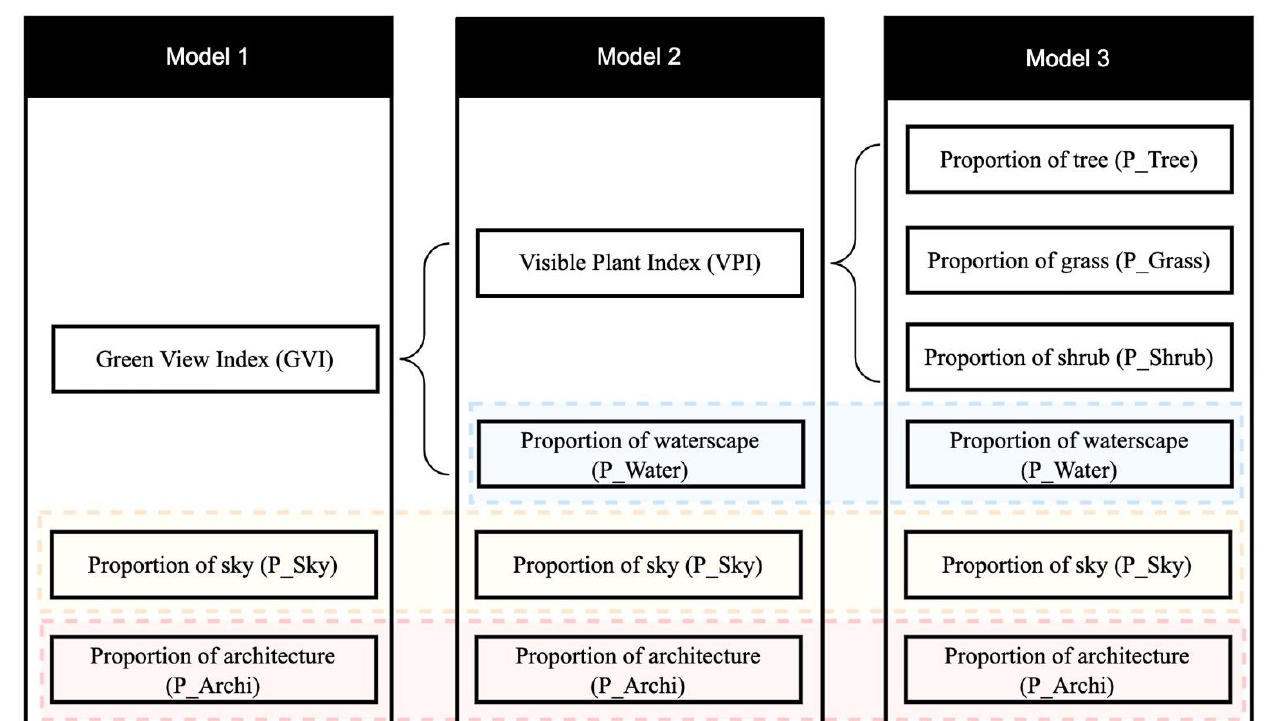
Figure 4. The containment relationships among the eight objectively measured variables. The three backwards multiple linear regression combinations of the eight independent variables.